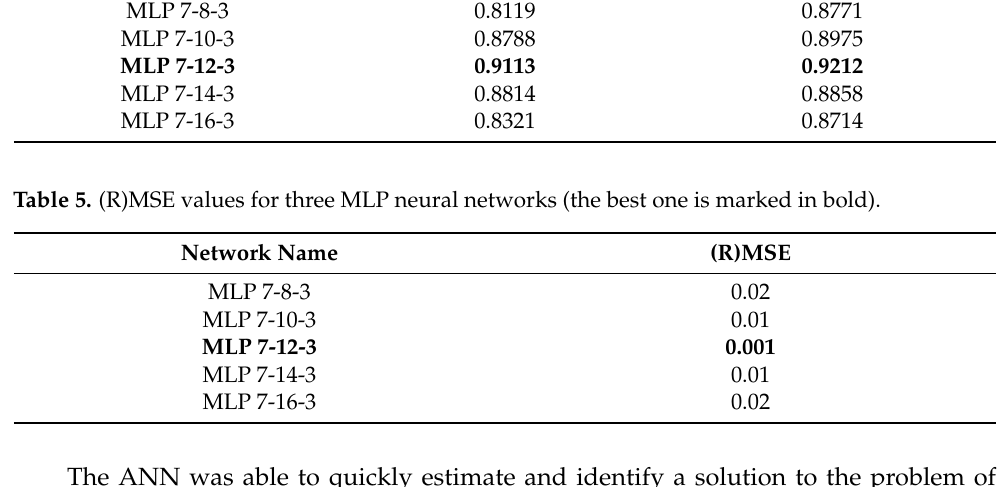
Table 2. Selected 3D printer parameters.